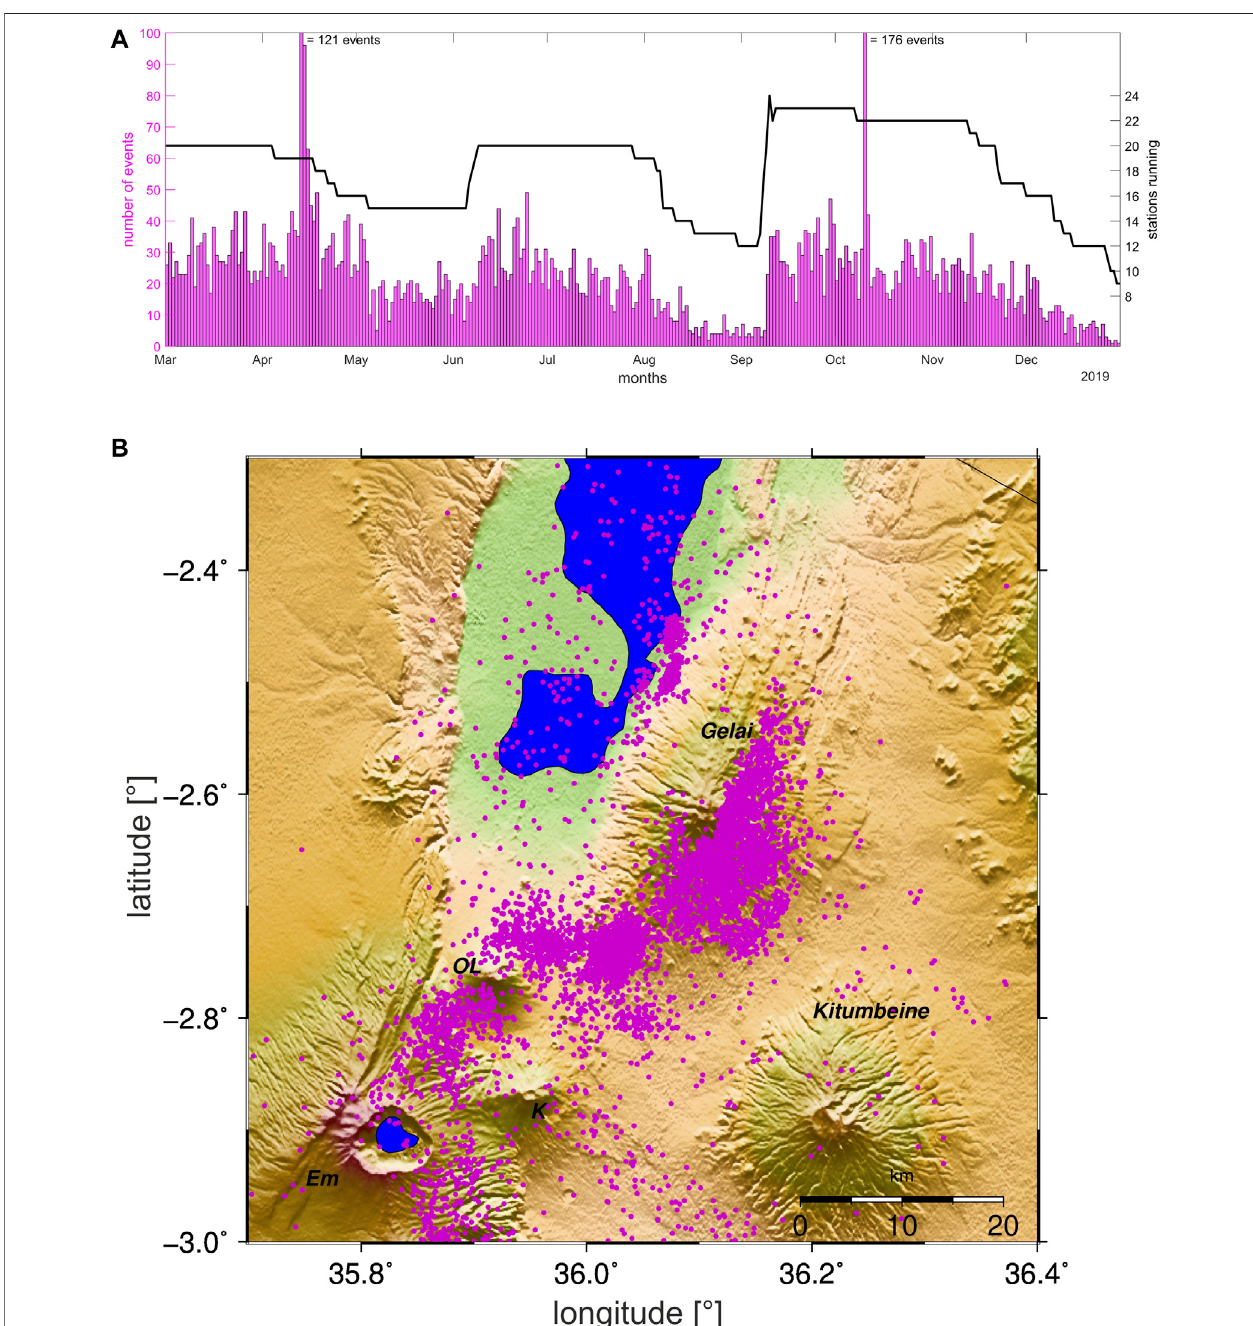
FIGURE 3 | (A) Histogram of well-located earthquakes per day (left y-axis) and superimposed numbers of running stations (right y-axis) . (B) Seismicity map, small circles show earthquakes.